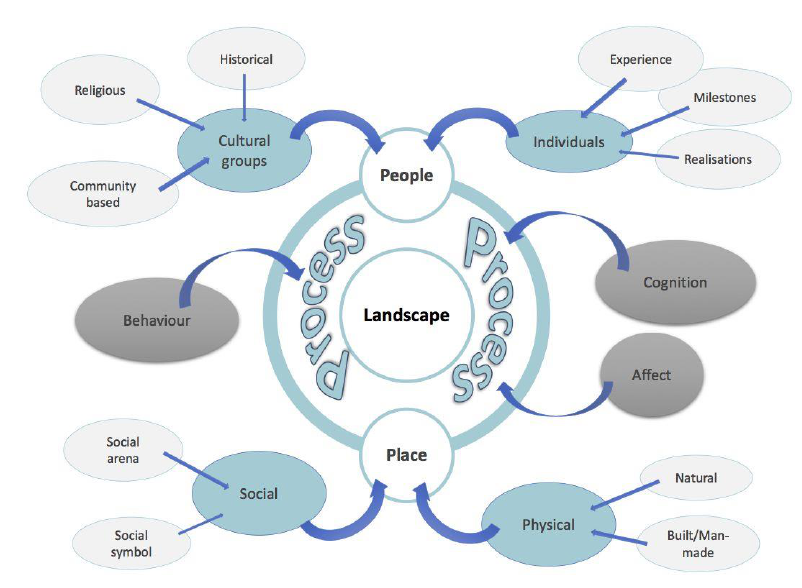
Figure 3. A process-oriented model of a Sense of Place, depicting the dynamic processes of the concept (Source: the authors).